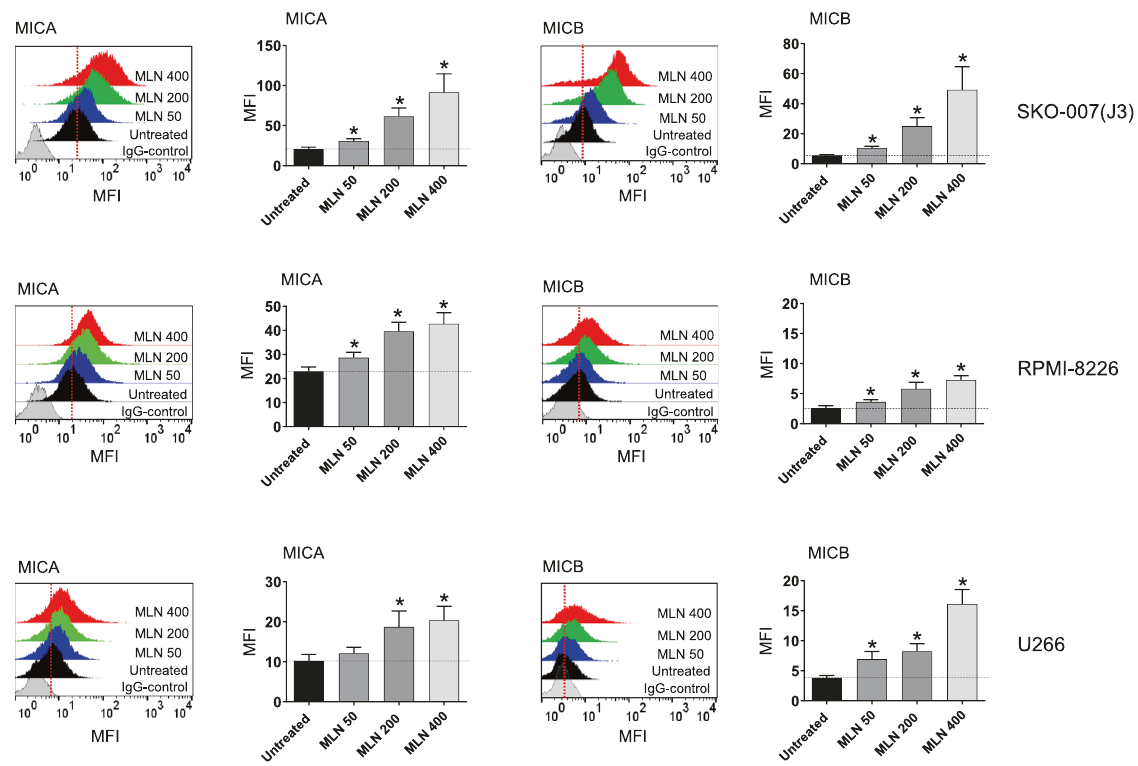
Fig. 1 MLN4924 upregulates MICA and MICB expression in human MM cell lines. MICA and MICB cell surface expression was analyzed by fl ow cytometry on SKO-007(J3), RPMI-8226 and U266 cells treated with MLN4924 (50 – 400 nM) for 72 h. Representative overlays are shown. Histograms represent the average of the mean fl uorescence intensity (MFI) values of the indicated ligand (with treatment-speci fi c isotype control MFI subtracted out). The MFI of MICA and MICB were calculated based on at least four independent experiments and statistical signi fi cance (±SEM) was evaluated by paired Student t test (* P <